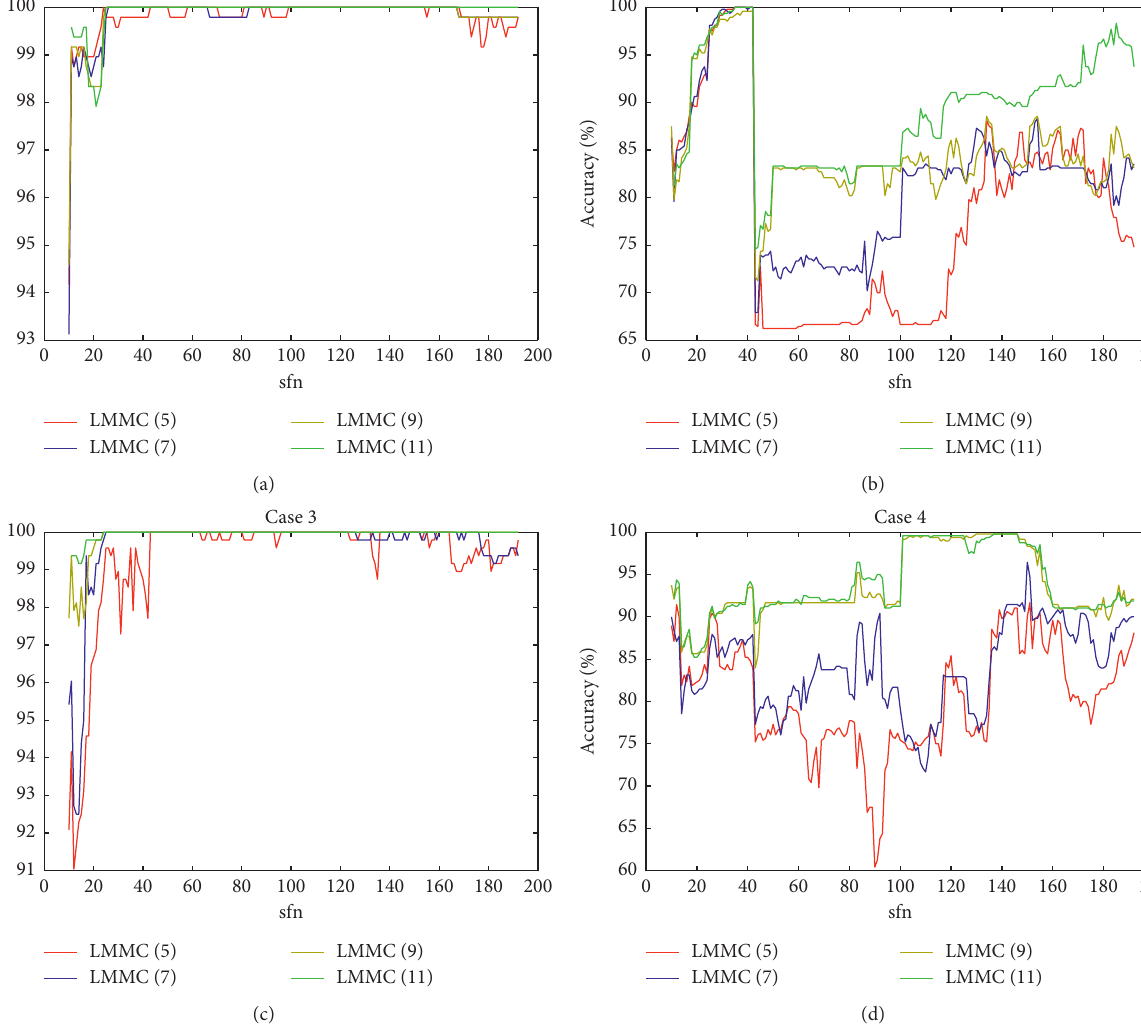
Figure 16: The curve representation of diagnosis results obtained by OFS-TSFRS-LMMC-SVM using DTCWPT with different dimension sizes for LMMC. The LMMC (5) represents that the number of dimension size is